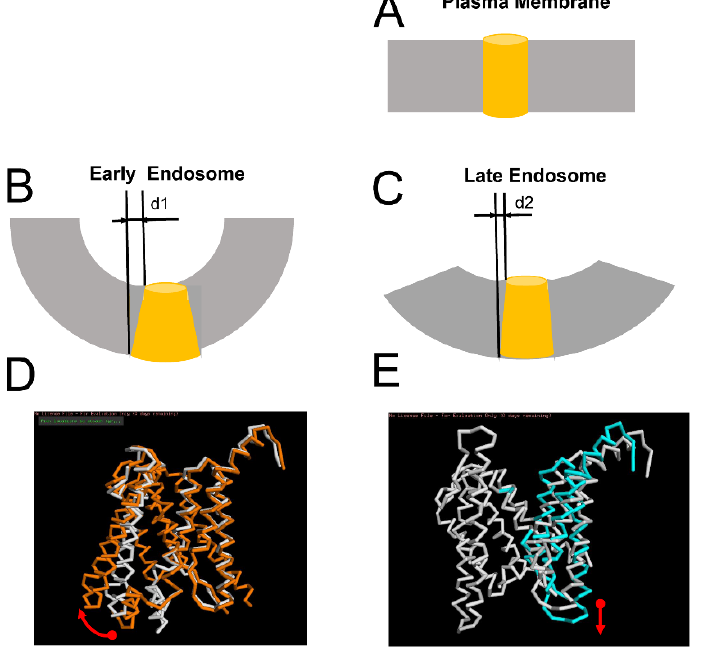
Figure 4. Effects of membrane curvature on γ -secretase activity. ( A ). PS1 is modeled as a cylinder shape in the plasma membrane ( B , C ) PS1 modeled as a truncated cone shape in the curved membrane of early ( B ) and late ( C ) endosomes. Expansion of the PS1 shape at the cytosolic surface of the membrane is shown as d1 ( B ) and d2 ( C ). ( D ). APP processing by γ -secretase is modeled as the lateral movement of PS1 in M1 conformation (shown as an overlay). The movement is a 7Å lateral movement between known PS1 structure 6IYC (white) and PS1 conformation in model M1 (orange). ( E ). APP processing by γ -secretase is modeled as a stretching movement of PS1 in M2 conformation (shown as an overlay). The movement is a 3Å expansion of the TM7 domain between the known PS1 structure 5FN3 (white) and PS1 conformation in model M2 (cyanate).